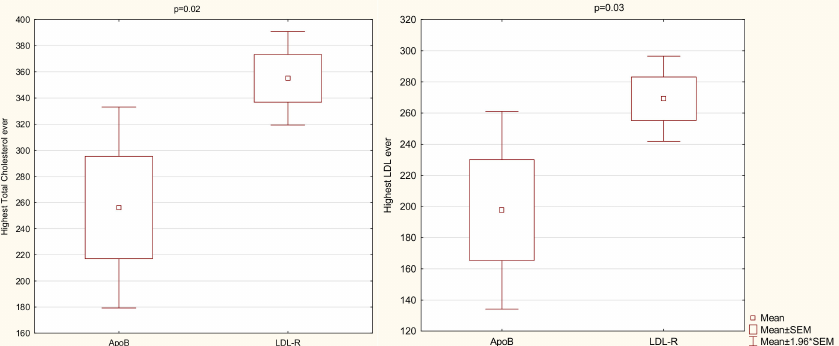
Figure 1. Highest TC and LDL-C ever depending on the underlying gene mutation. Abbrevia- tions: LDL-C—low-density lipoprotein cholesterol, LDLR—low-density lipoprotein receptor, ApoB— apolipoprotein B, Min—minimum, Max—maximum, SEM—standard error of the